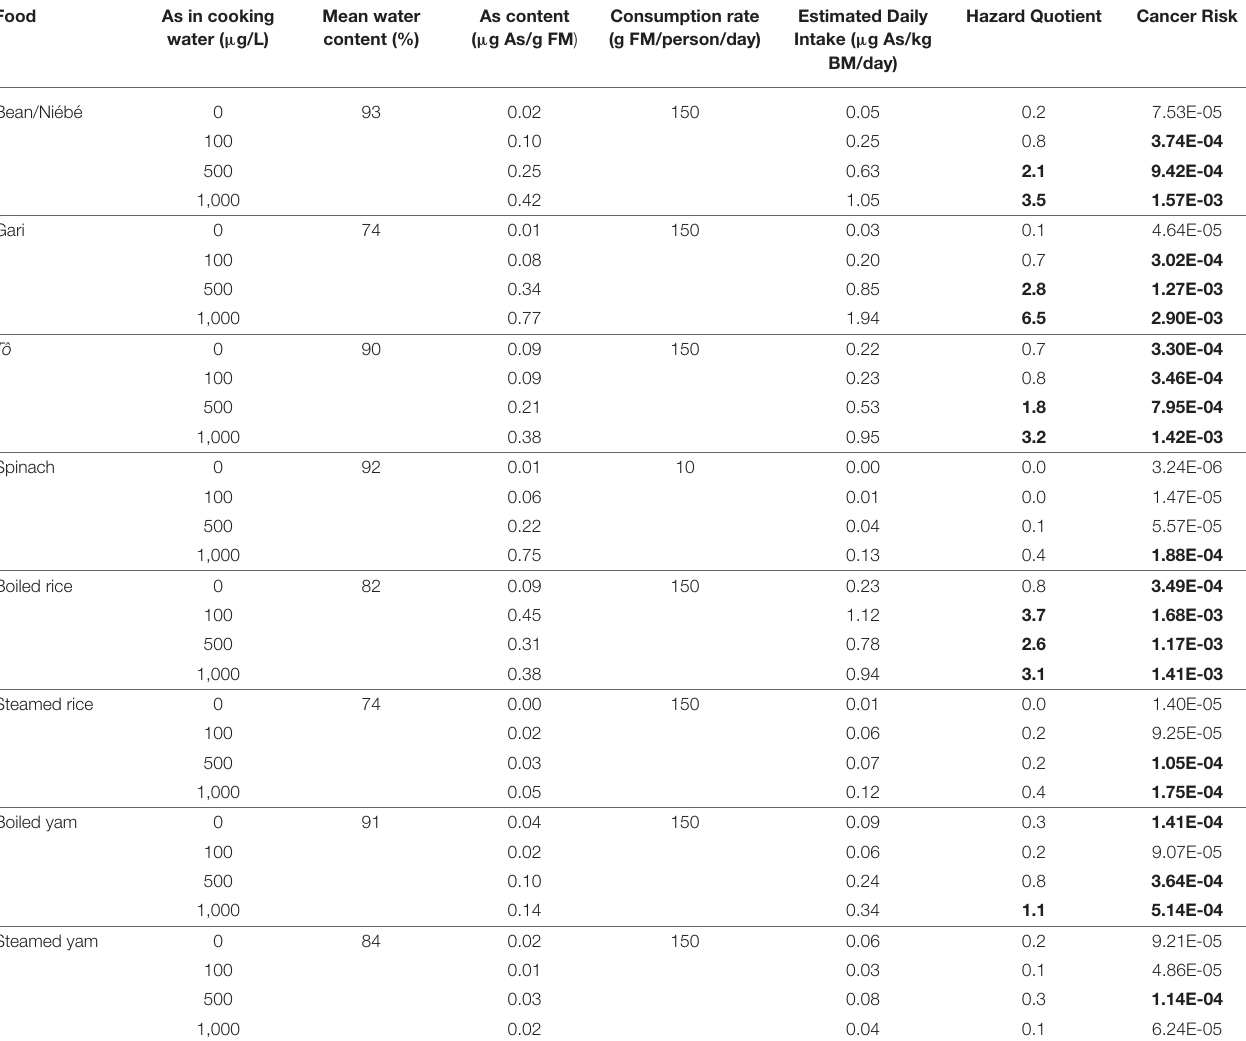
TABLE 4 | Hazard quotient (HQ) and cancer risk (CR) for the ingestion of prepared food as a function of As in cooking water (FM = fresh mass and BM = body mass).